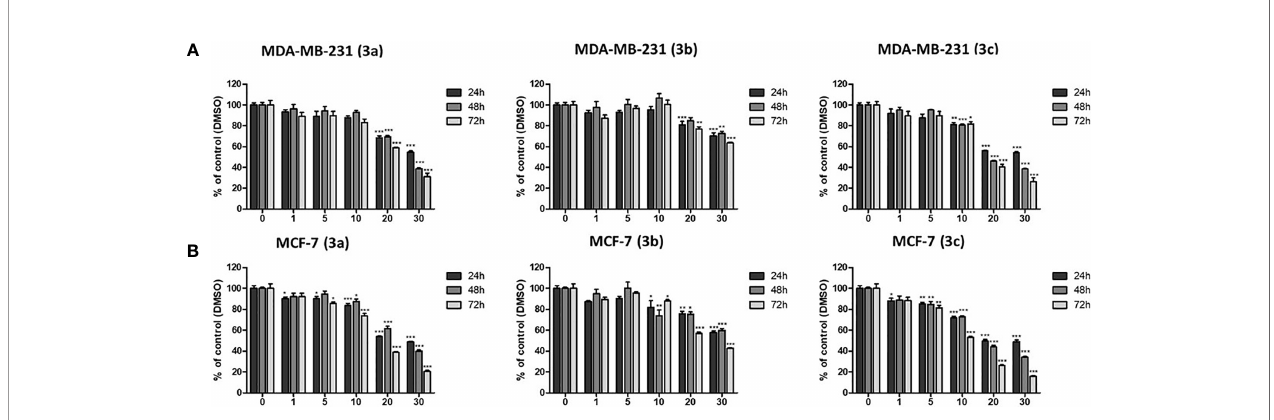
FIGURE 4 | The cytotoxic effects on 3a , 3b , and 3c in MDA-MB-231, and MCF-7 cell lines. (A) The MDA-MB-231 and (B) MCF-7 cells were treated with each compounds as various concentrations (0 – 30 m M) for 24, 48, and 72 h. Then, the cell viability was measured by MTT assay. * p < 0.05 vs . untreated group; ** p < 0.01 vs . untreated group; *** p < 0.001 vs . untreated